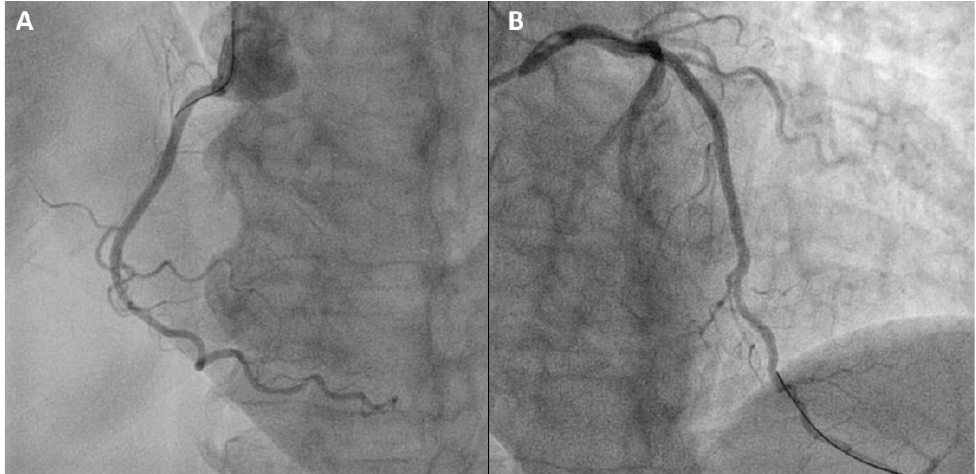
Figure 2. Percutaneous coronary intervention in the patient case described in the case vignette. ( A ) The right coronary artery lesion was treated with the implant of a Xience Prime (2.75 × 28 mm) stent. ( B ) The proximal and mid left anterior descending coronary artery lesions were treated with the implantation of three Xience Prime (3.0 × 38 mm, 3.0 × 15 mm, 2.75 × 15 mm) stents.